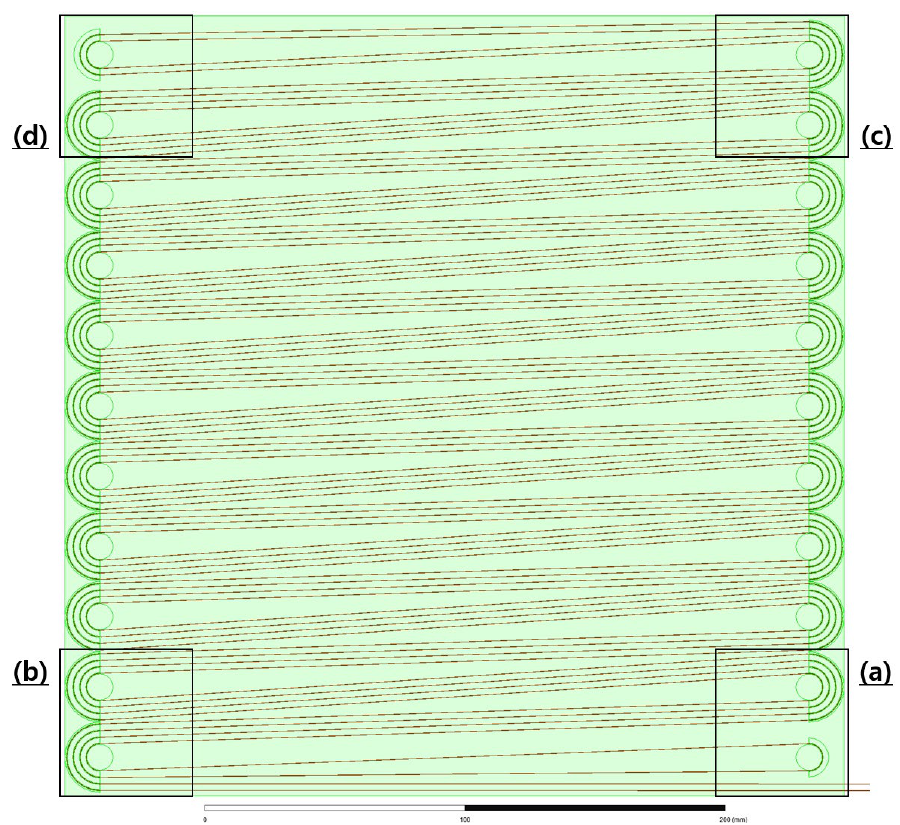
Figure 4. Simulation design model of the bifilar-meander type: ( a ) bottom right part, ( b ) bottom left part, ( c ) top right part, ( d ) top left part.